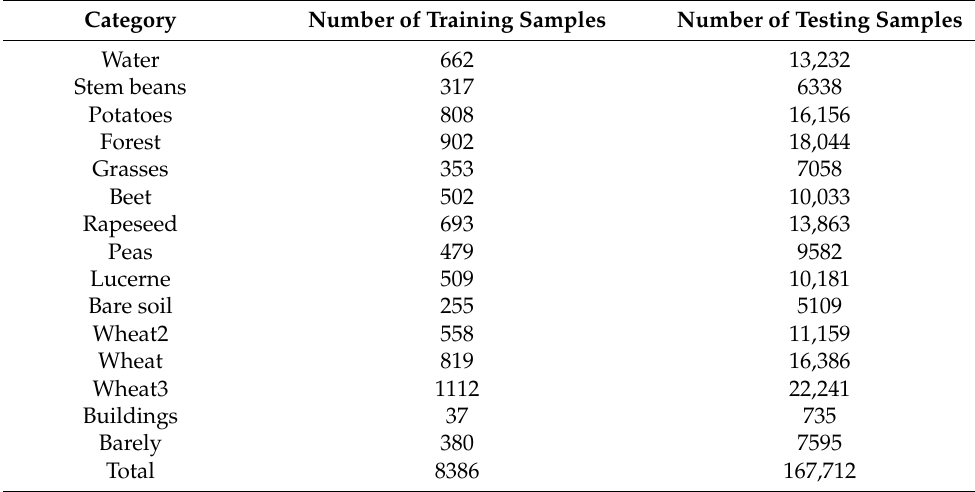
Table 5. The distribution of training samples in each category for the scattering vector model (SVM) in Flevoland image.